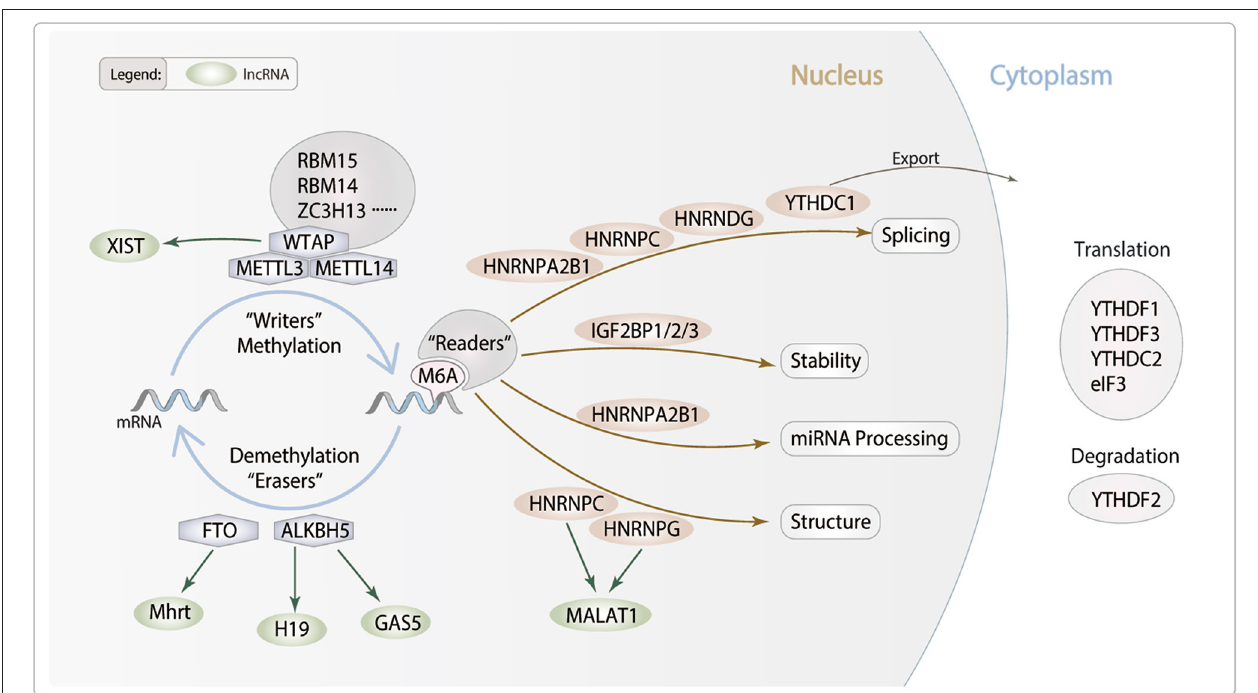
FIGURE 1 | Potential role of lncRNA m6A modification in cardiac remodeling. m6A is deposited by “Writers” (METTL3/14, WTAP, RBM14/15 and ZC3H13), removed by “Erasers” (FTO and ALKBH5), and recognized by “Readers” (YTHDC1/2, YTHDF1/2/3, IGF2BP1/2/3, HNRNPA2B1, HNRNPC, HNRNPG and eIF3). m6A modifications can regulate RNA processing, including splicing, nuclear exports, stability and translation. We hypothesis lncRNA m6A modification which may modulate particular pathophysiological process of cardiac